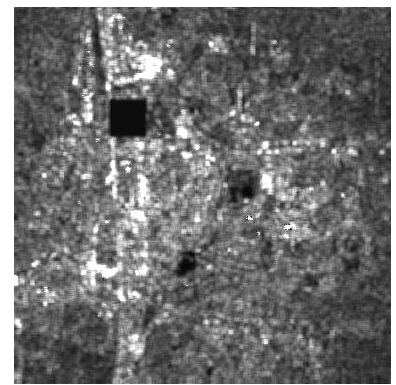
Figure 4. ENVISAT SAR data(HH, 2005)